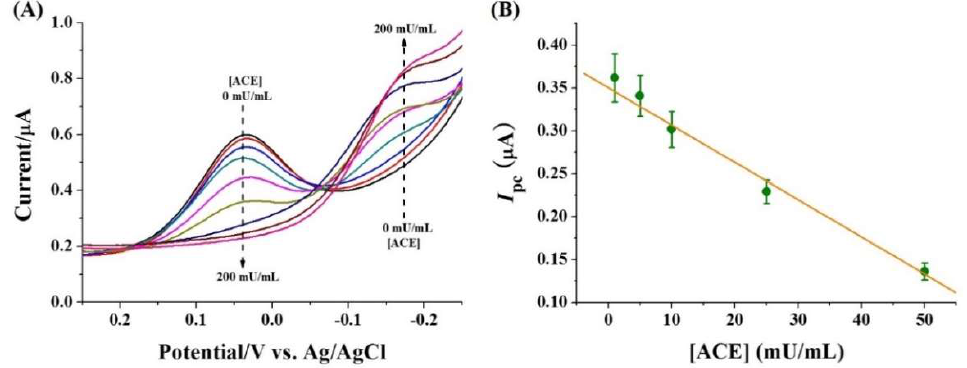
Figure 4. ( A ) DPVs for the detection of different concentrations of ACE (0, 1, 5, 10, 25, 50, 100 and 200 mU/mL) and ( B ) calibration plots for the detection of ACE in the range of 1~50 mU/mL. The concentrations of substrate and Cu(II) were 50 μM.